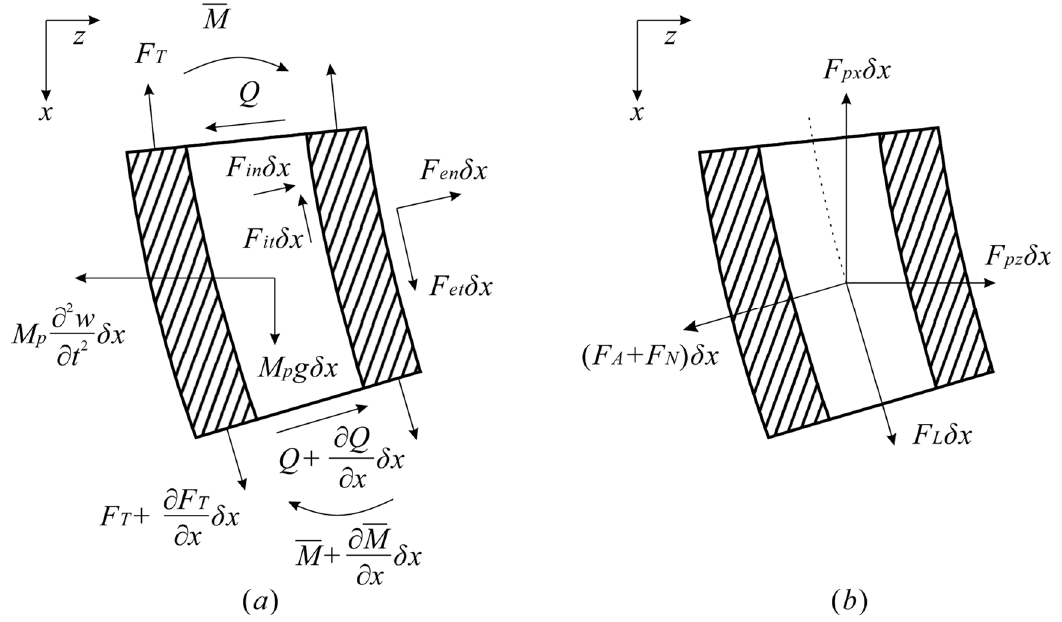
Figure 4. ( a ) Forces acting on an element of length δ x of the cantilevered pipe. ( b ) Forces due to the outside fluid acting on an element δ x of the cantilevered pipe.